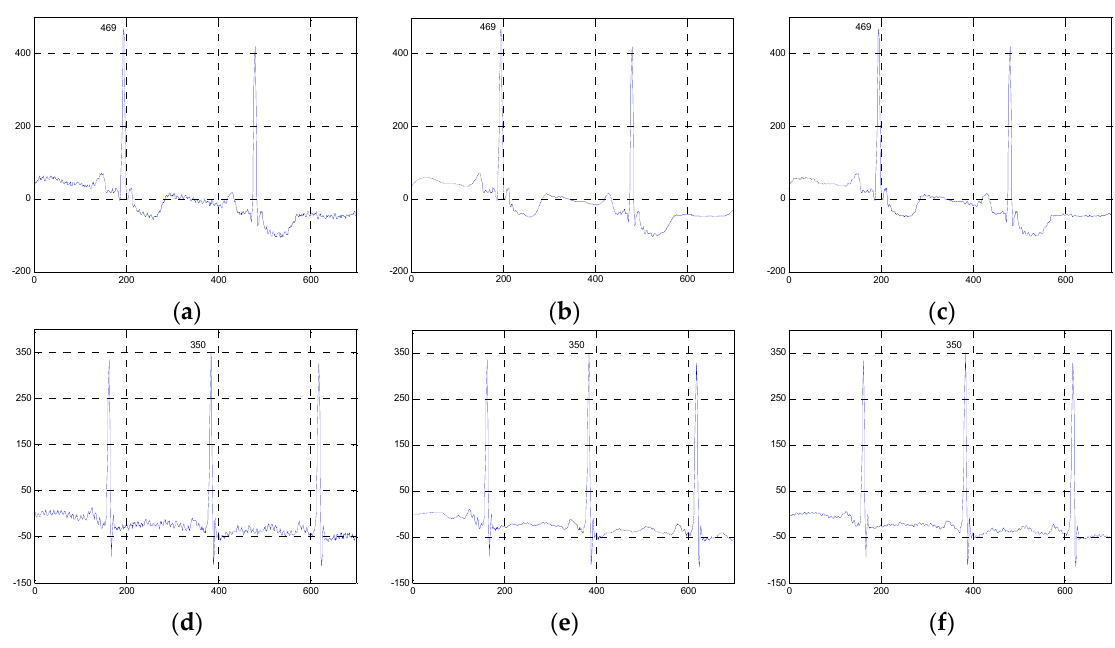
Figure 15. Comparison of the denoised results for the ESMD-NLM and NLM methods operating on the 13649_04m.dat and 12713_04m.dat in the third group of clinical ECG signals. ( a ) The clinical ECG signal (13649_04m.dat); ( b ) the ESMD-NLM method (13649_04m.dat); ( c ) the NLM method (13649_04m.dat); ( d ) the clinical ECG signal (12713_04m.dat); ( e ) the ESMD-NLM method (12713_04m.dat); ( f ) the NLM method (12713_04m.dat).